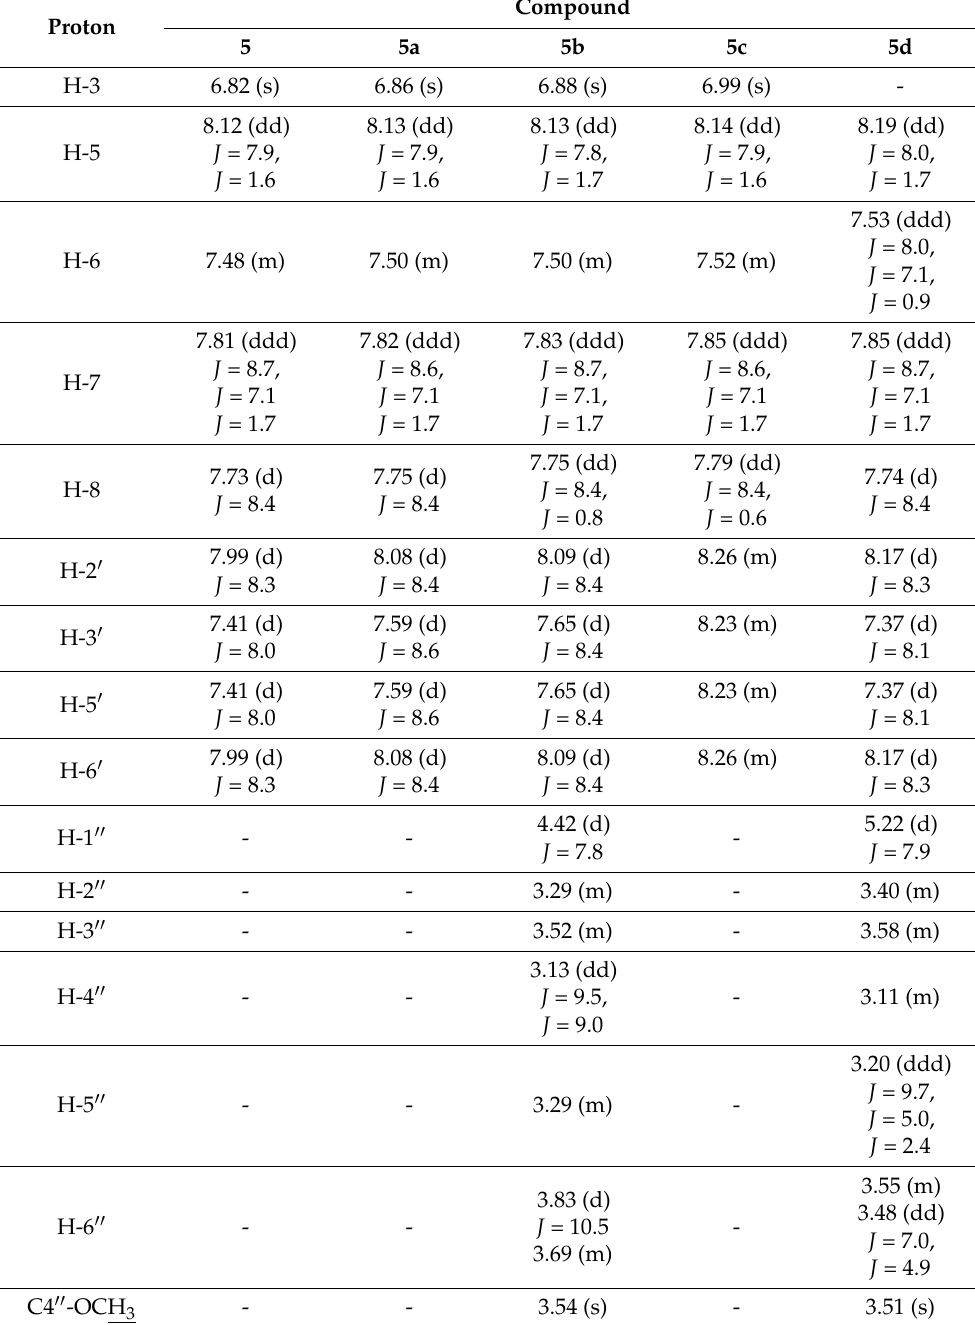
Table 3. 1 H-NMR chemical shifts δ (ppm) and coupling constants J (Hz) of 4 (cid:48) -methylflavone ( 5 ) and products of its biotransformation 5a – 5d in Acetone-d6, 600 MHz (Supplementary Materials: Figures S94, S95, S113, S114, S131–S133, S153, S154 and